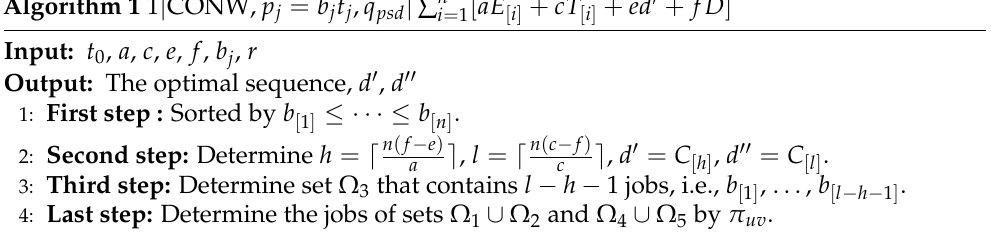
Algorithm 1 1 | CONW, p j = b j t j , q psd | ∑ n